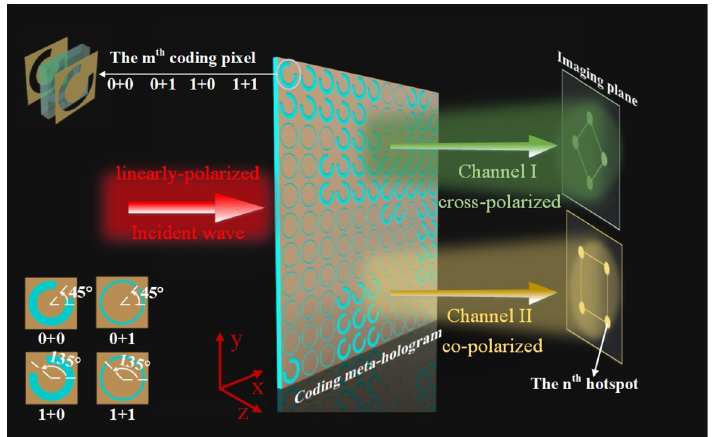
plane wave. Two different images (a rhombus and a squares, here) can be simultaneously projected in the two near-field